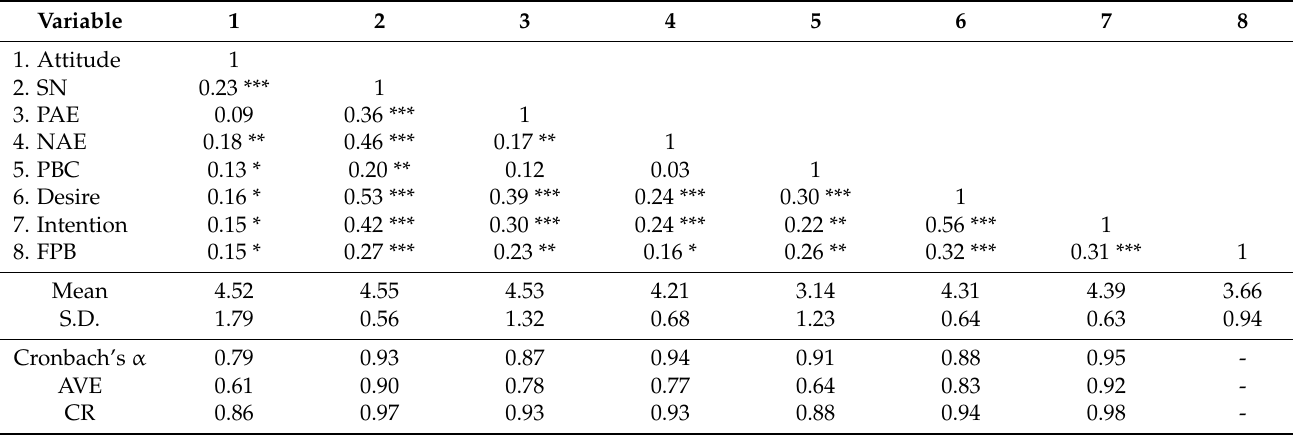
Table 2. Summary results of correlation, reliability, and validity